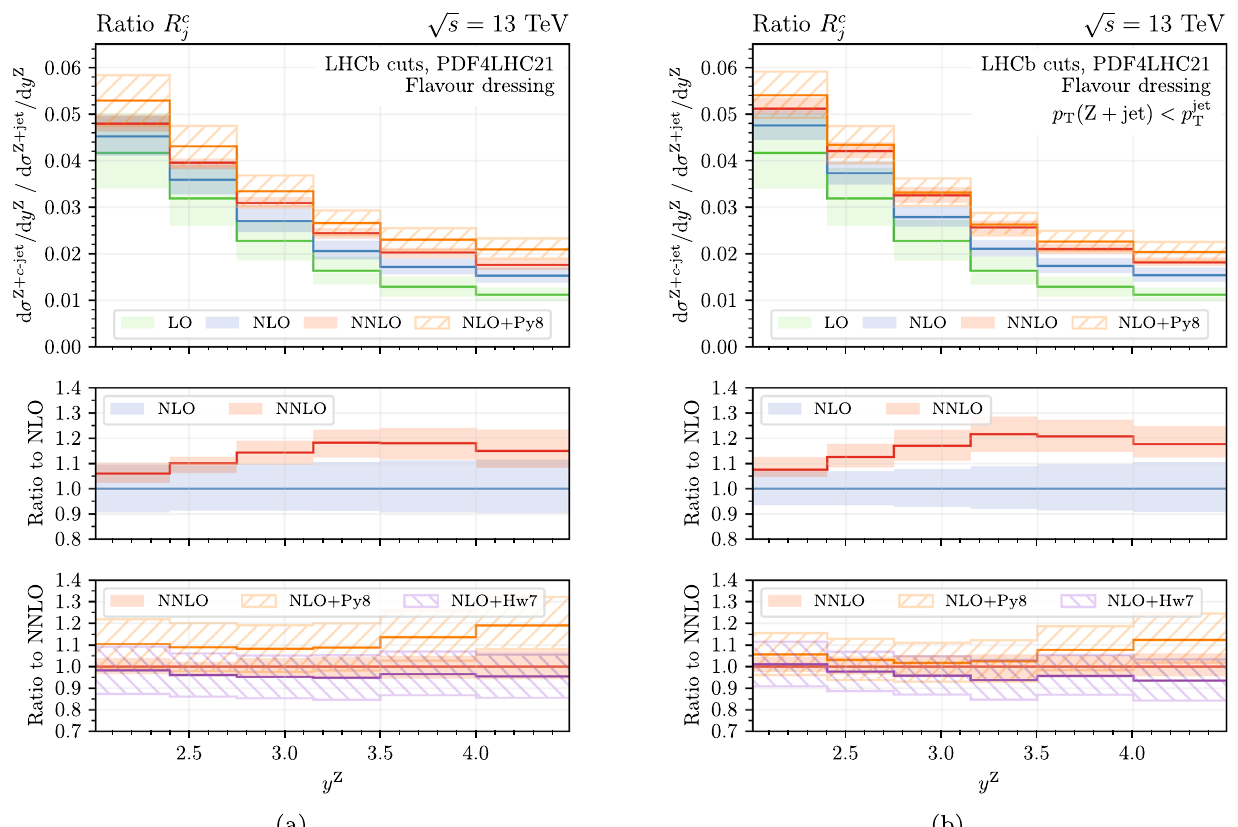
= NNLO (red); NLO+PS predictions with Pythia8 (orange) or Her- j wig7 (purple) as parton showers. A dynamical cut on the transverse momentum of the Z + jet system is further applied in